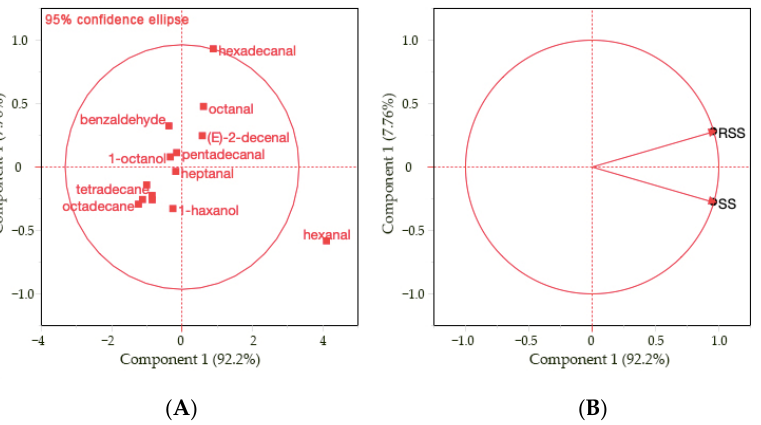
Figure 1. Score plot ( A ) and a loading plot ( B ) of principal component analysis (PCA) of 14 significant VCs found in seared and reverse-seared steaks.